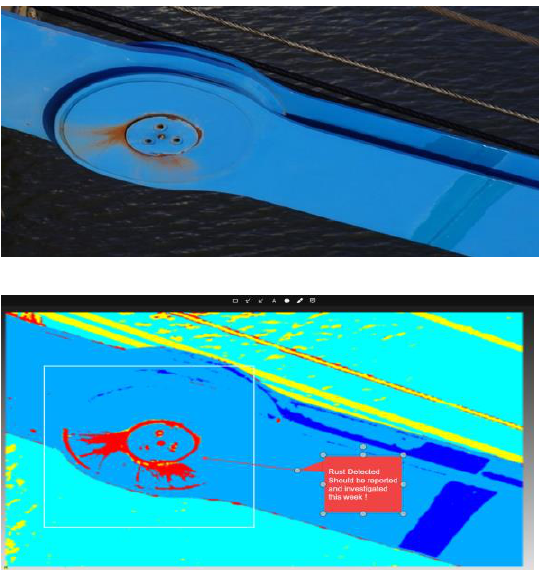
Figure 7 . An example of a crane neuralgic area image captured by UAV (above) and its annotated result showing the rust detected in red (below) using ML methods. Both are stored in the geodatabase and can be retrieved by